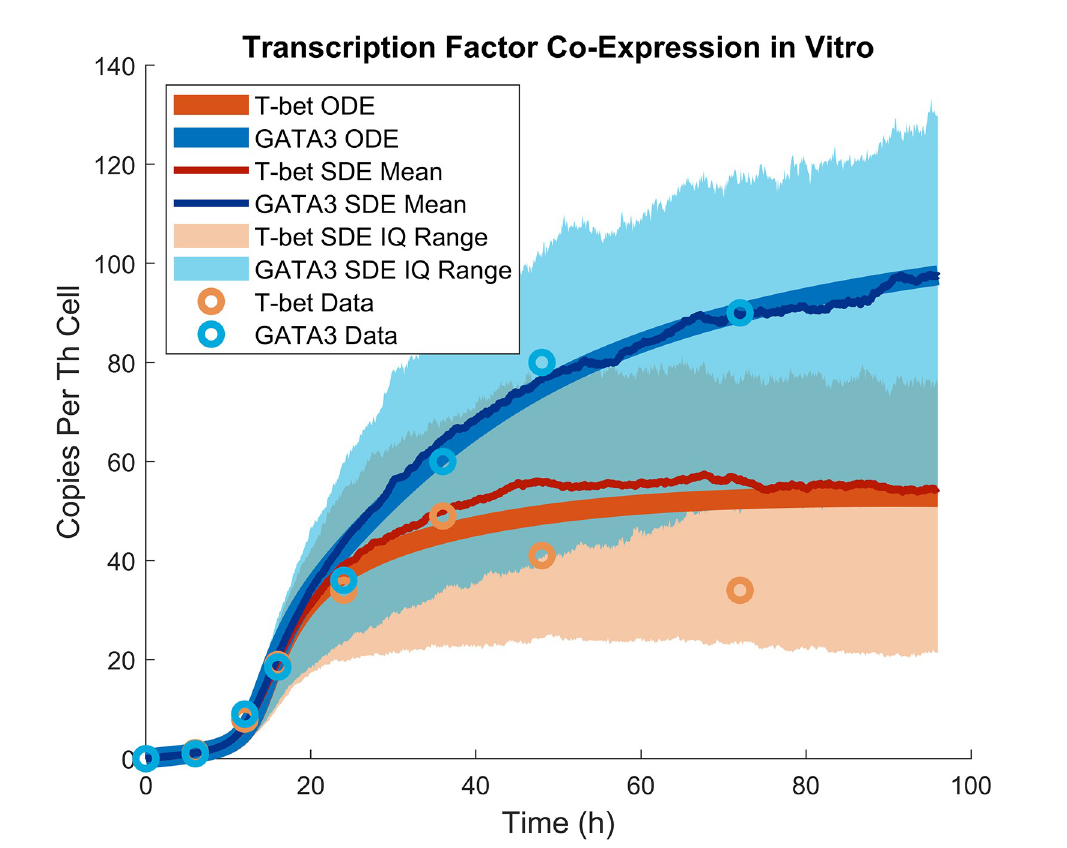
Fig 3. The model predicts the dynamics of transcription factor expression under in vitro conditions with no exogeneous effector stimulation. Experiment and model were both run at 2 � 10 6 cells/mL. Data are replotted from [34]. SDE mean and interquartile range are drawn from 1000 SDE sample